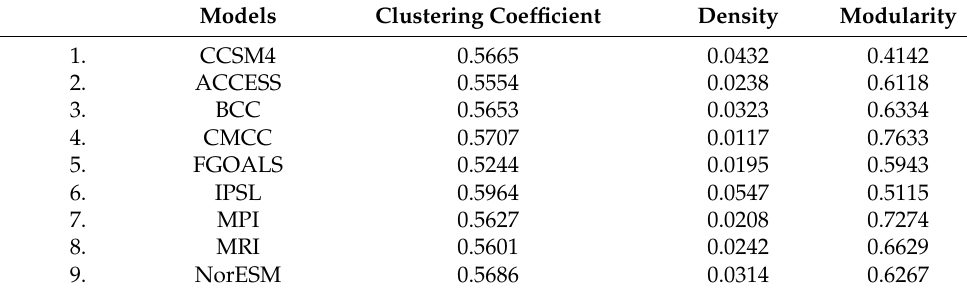
Table 2. Topology characteristics of the PDSI-based network.